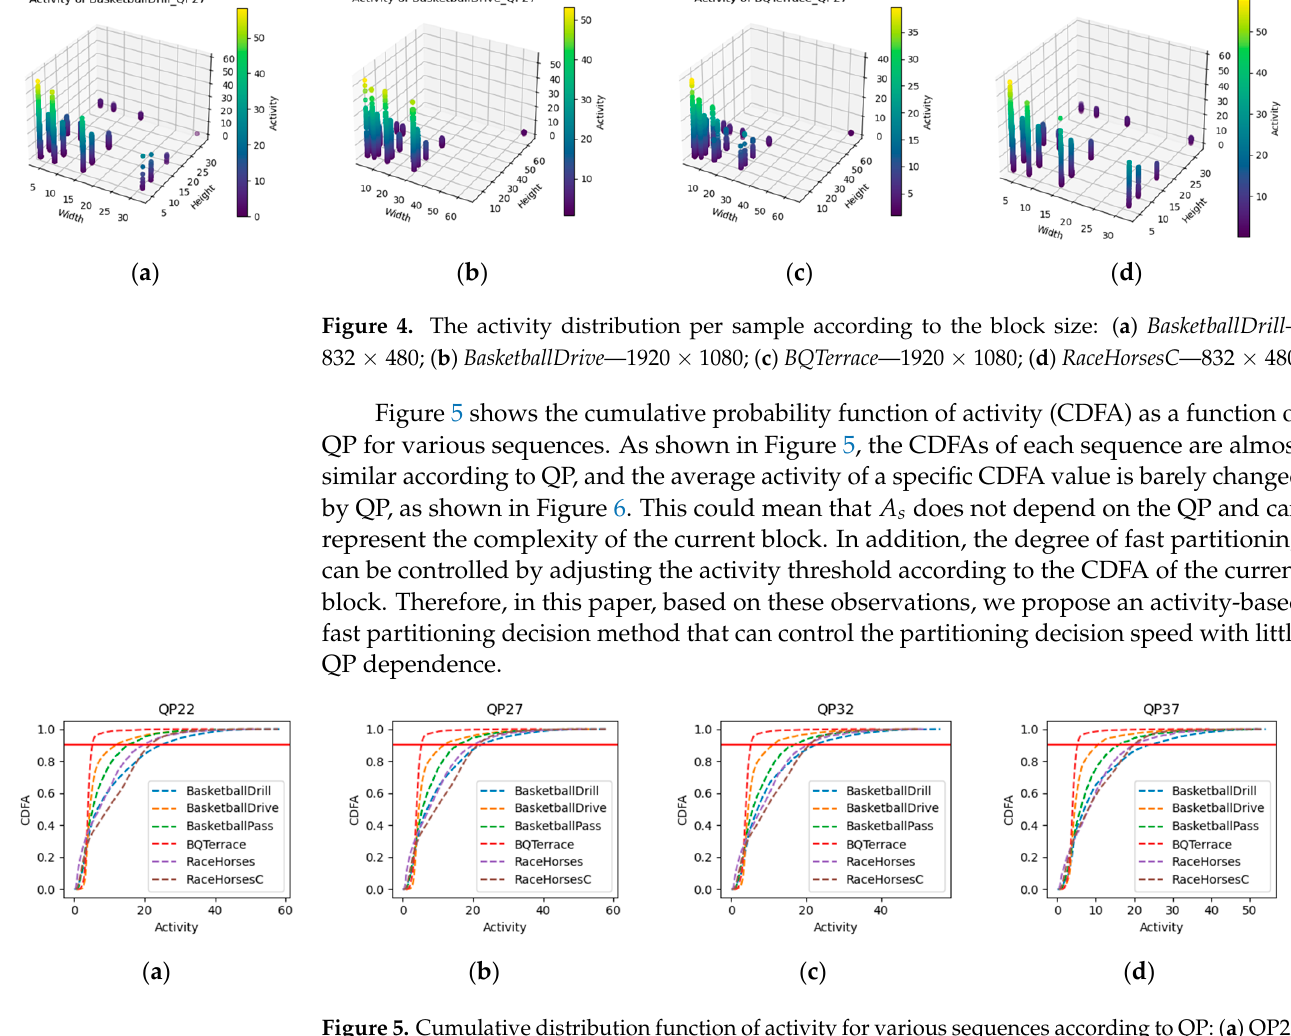
Figure 6. Changes in average activity according to QPs at fixed value of CDFA. 3.2. Proposed Activity-Based Fast Block Partitioning In this section, we describe the proposed fast block partitioning decision method based on the observations described in Section 3.1. In VVC, block partitioning is per- formed in the order of QT-BT-TT. Then, an optimal block partition is determined through RD cost competition for all possible block partitions. The proposed method rapidly deter- mines the block partitions by skipping the RD computation for all or parts of the BT and/or TT partitions. Because it skips the RD computation for some partitioning modes, the en- coding complexity can be reduced. In the first step, block partitioning is terminated early based on the block size and activity per sample 𝐴 (cid:3046) . In this step, four partitioning modes, namely {BT-H, BT-V, TT-H, TT-V}, can be skipped. Next, the block partitioning mode is determined using activity and directionality. To reduce computational complexity, including derivation of samples in the areas required for gradient calculation other than the current block, the areas outside the current block are padded with samples that are the closest to the current block. As shown in Figure 4, the larger the block size, the lower is the activity. To quantita- tively verify this tendency, we observed the statistical characteristics of activity according to the block size. Tables 1 and 2 summarize our analysis of the encoding results shown in Figure 4. The posterior probability was calculated to determine block partitioning accord- ing to the block size and 𝐴 (cid:3046) . The prior probability condition for the block size was defined as follows: